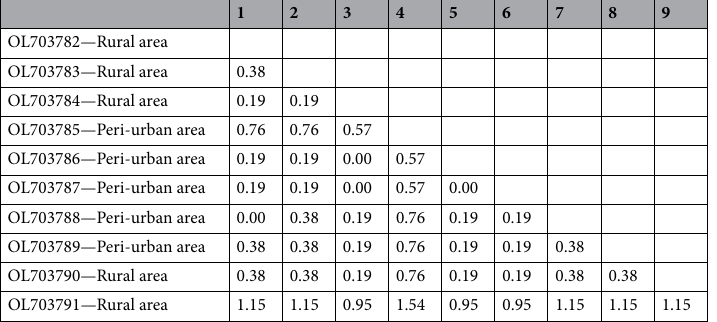
Table 1. Evolutionary distance (%) between p4b gene sequences of Avipoxvirus obtained from Culex spp. in rural and peri-urban areas in the municipality of Seropedica, Rio de Janeiro,